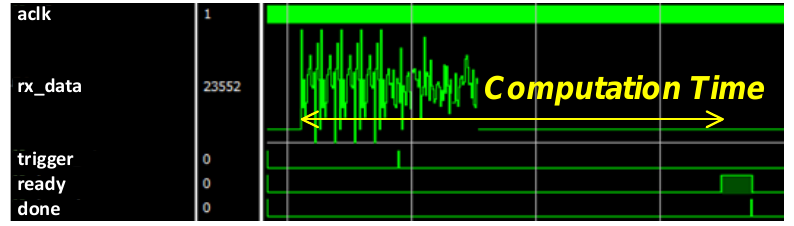
Fig. 8. Receiver timing